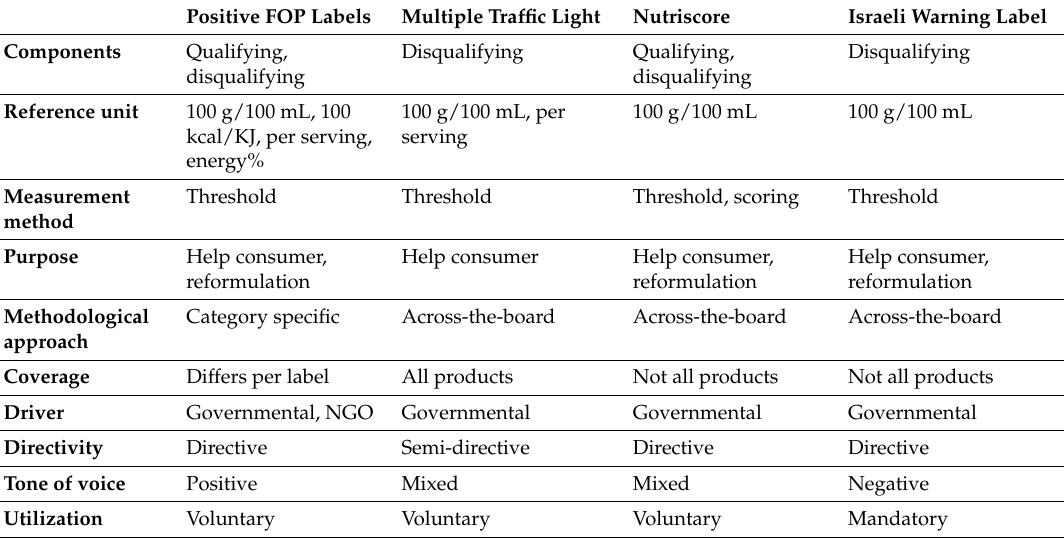
Table 2. Characteristics of positive, mixed and negative FOP labels in